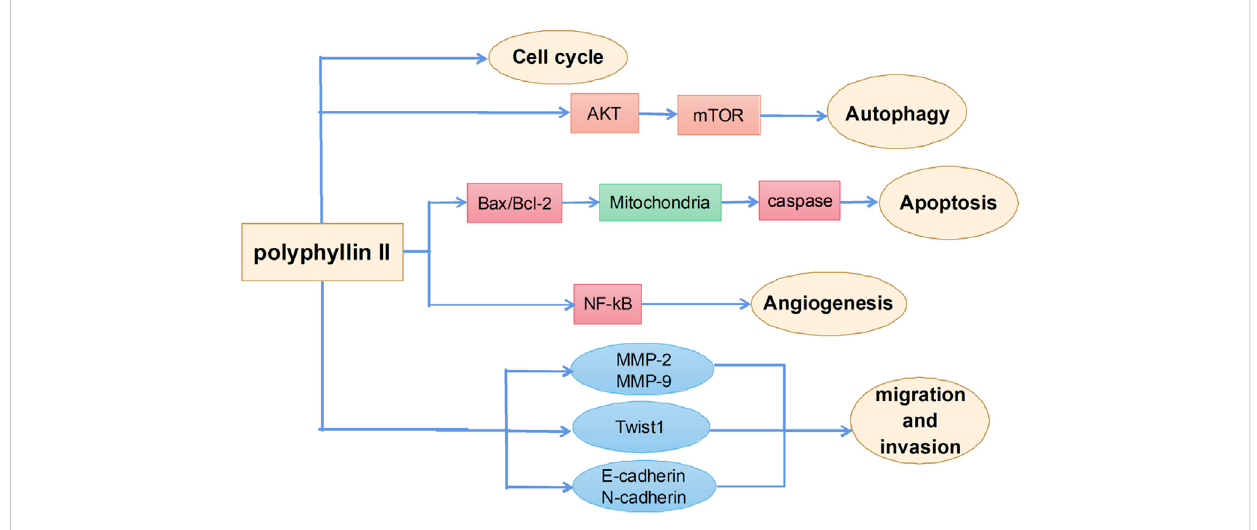
The primary mechanism for the anti-tumor effects of Polyphyllin